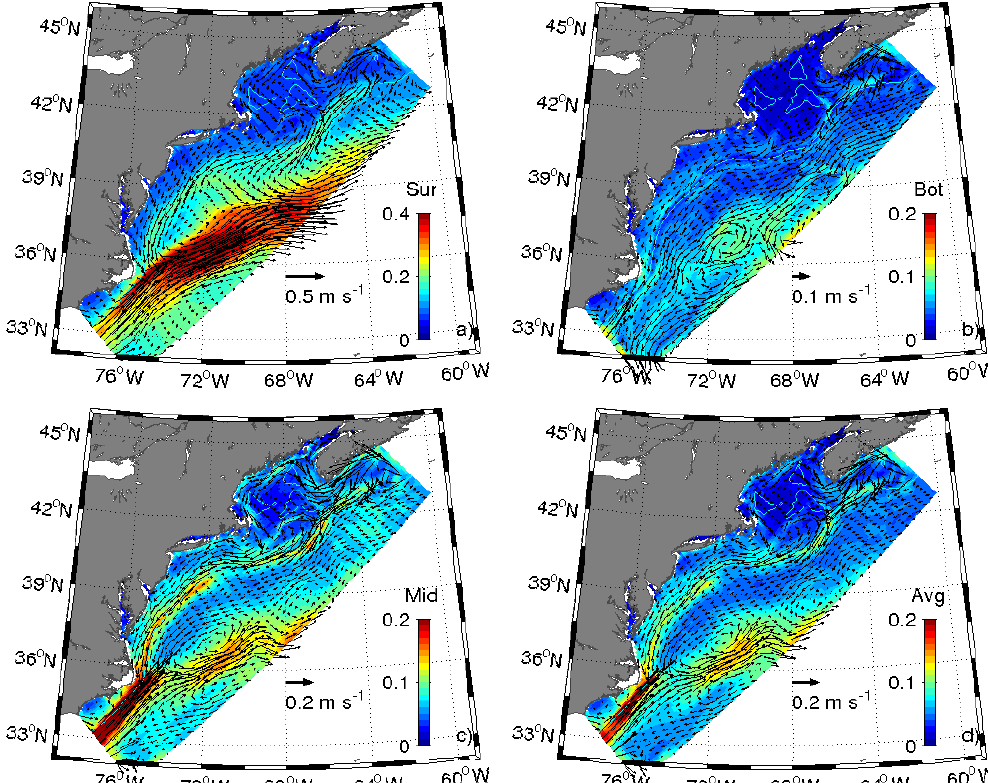
Figure 8. Domain-wide mean velocity fields (vectors) and their associated speed standard deviations (color contour) at the surface (a) , bottom (b) , and mid-depth (c) . Depth-averaged velocity field is shown in (d) . Near-surface currents are larger than those near the bottom; note scale